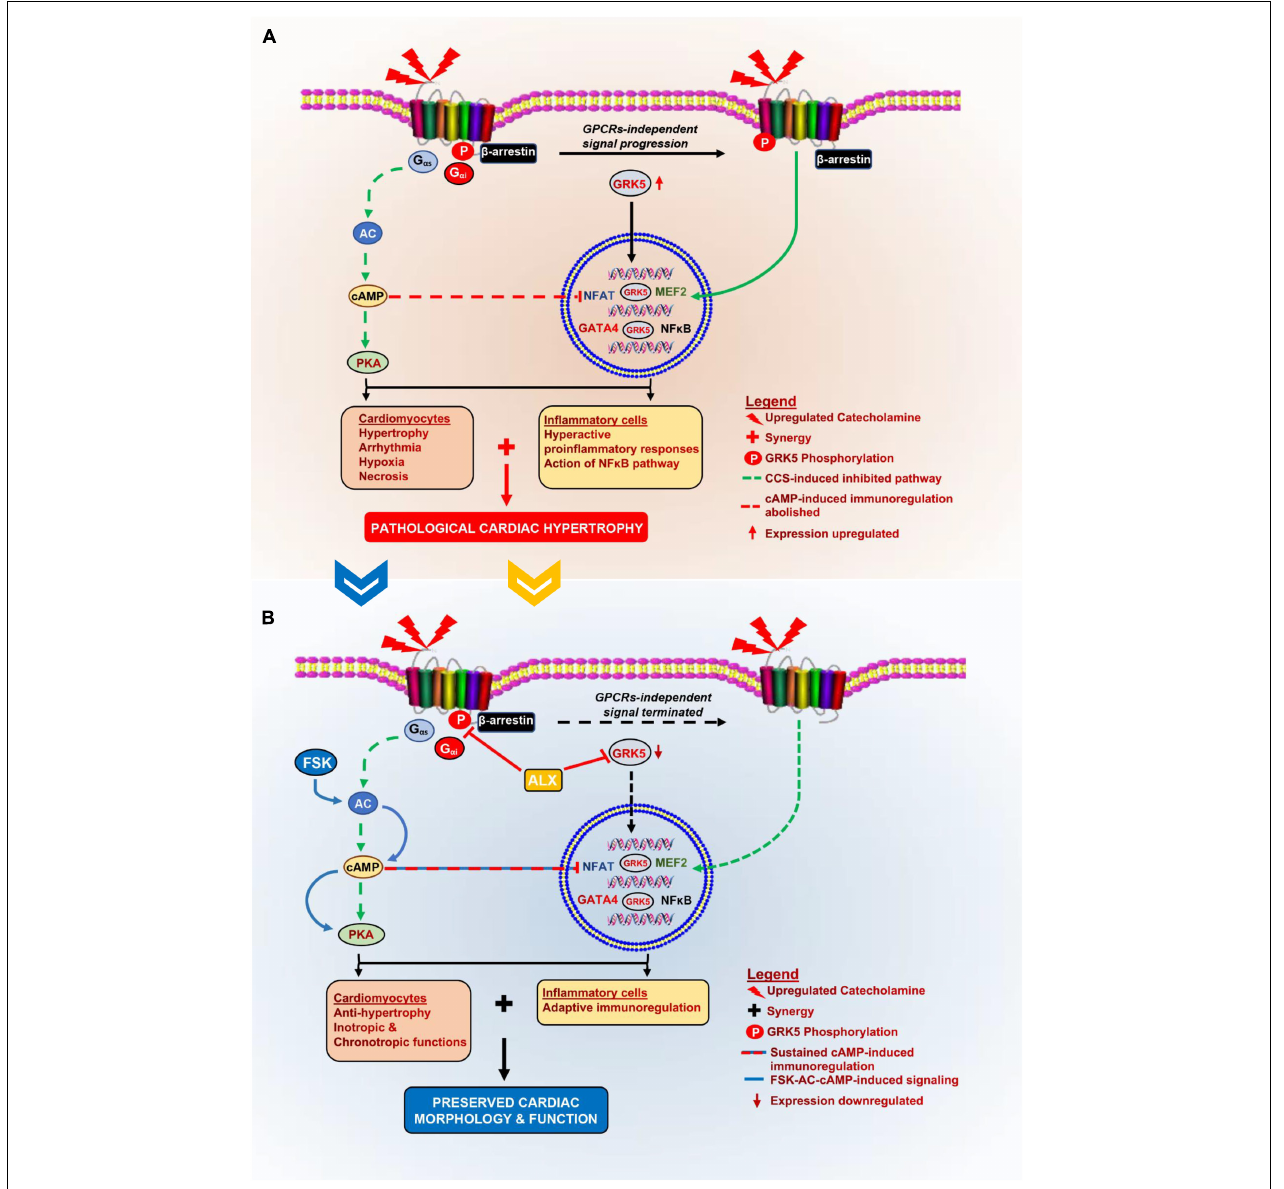
FIGURE 6 | Schematics of the pathomechanism of isoproterenol-induced cardiomyopathy and the mechanisms of ALX and FSK combination treatment. (A) During CCS, G α s -AC is decoupled from β ARs, thereby inhibiting cAMP synthesis, which affects cardiac function and immunoregulation in the myocardia adversely. Also, GRK5 upregulates and phosphorylates β ARs as well as translocations into the nuclei to induce GPCRs-independent stimuli signaling. The nuclear activity of GRK5 induces the activation of cardiomyocyte hypertrophy transcriptional factors. These result in excessive cardiomyocyte hypertrophy and hyperactive proinflammatory responses. At the same time, cAMP-mediated adaptive immunoregulation is abolished. The synergy of these cascades results in the exacerbation of collagen deposits which pathologically remodels the heart. (B) The administration of ALX and FSK combination facilitates ALX-GRK5 inhibition (expressions and